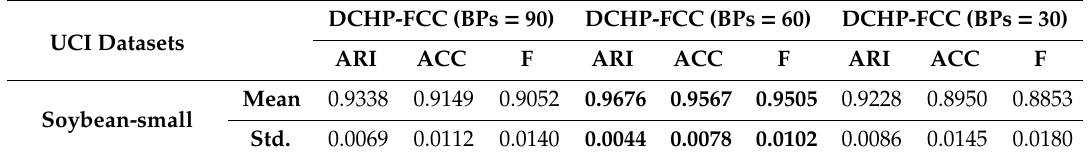
Table 2. The preliminary experiments on the Soybean-small dataset. UCI Datasets